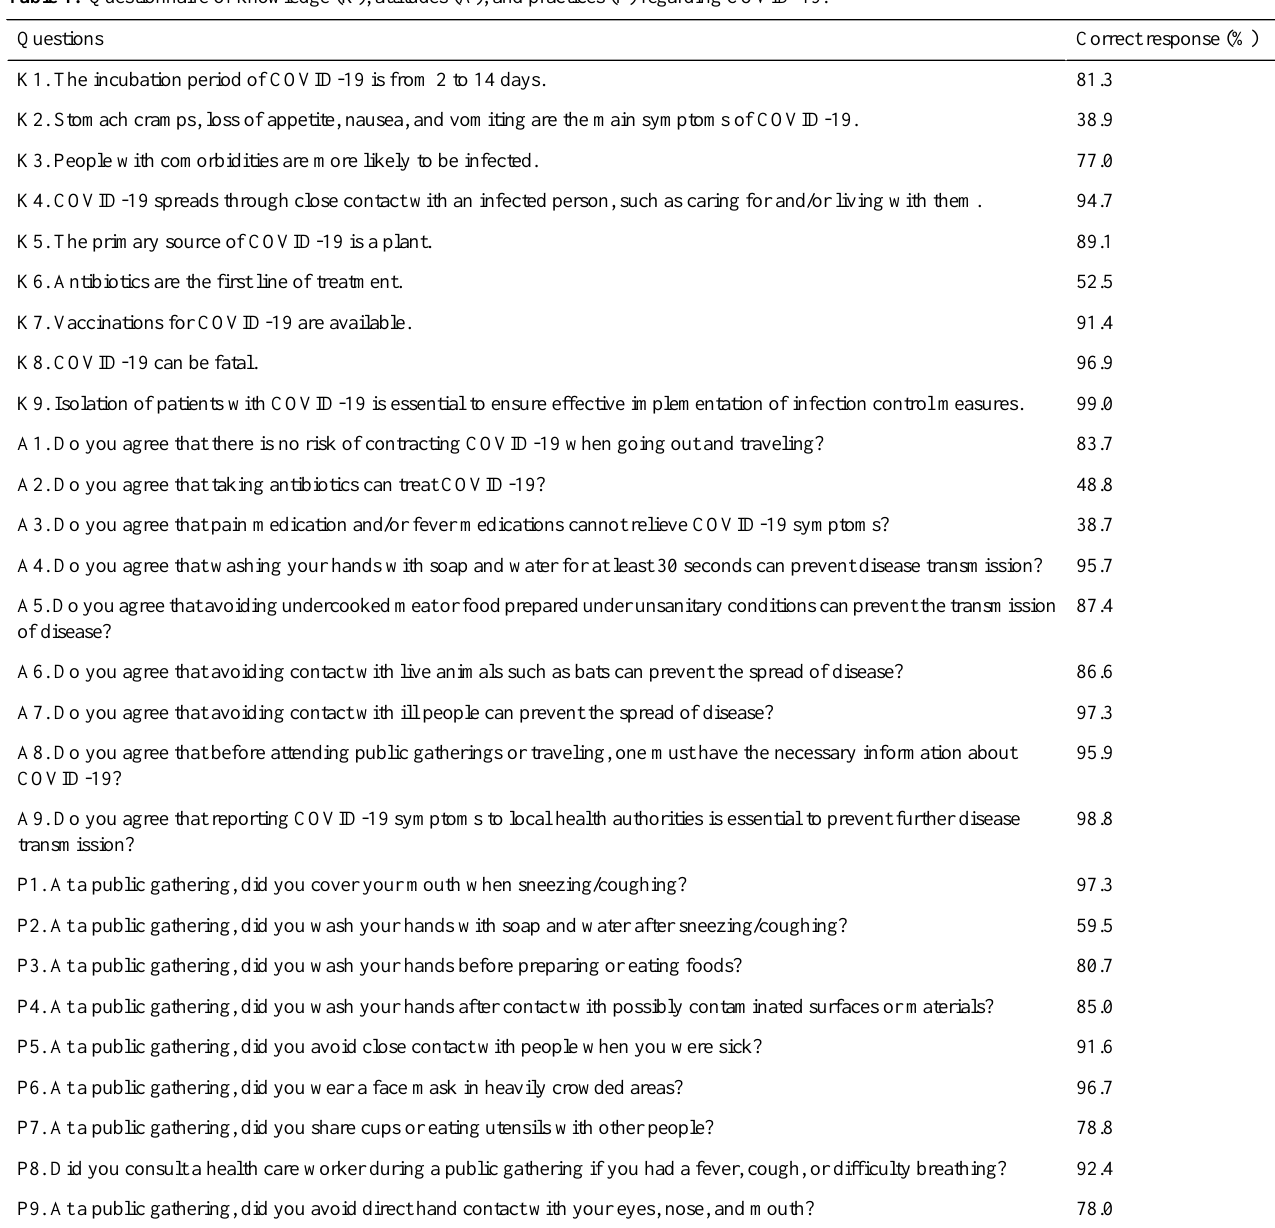
Table 1. Questionnaire of knowledge (K), attitudes (A), and practices (P) regarding COVID-19.